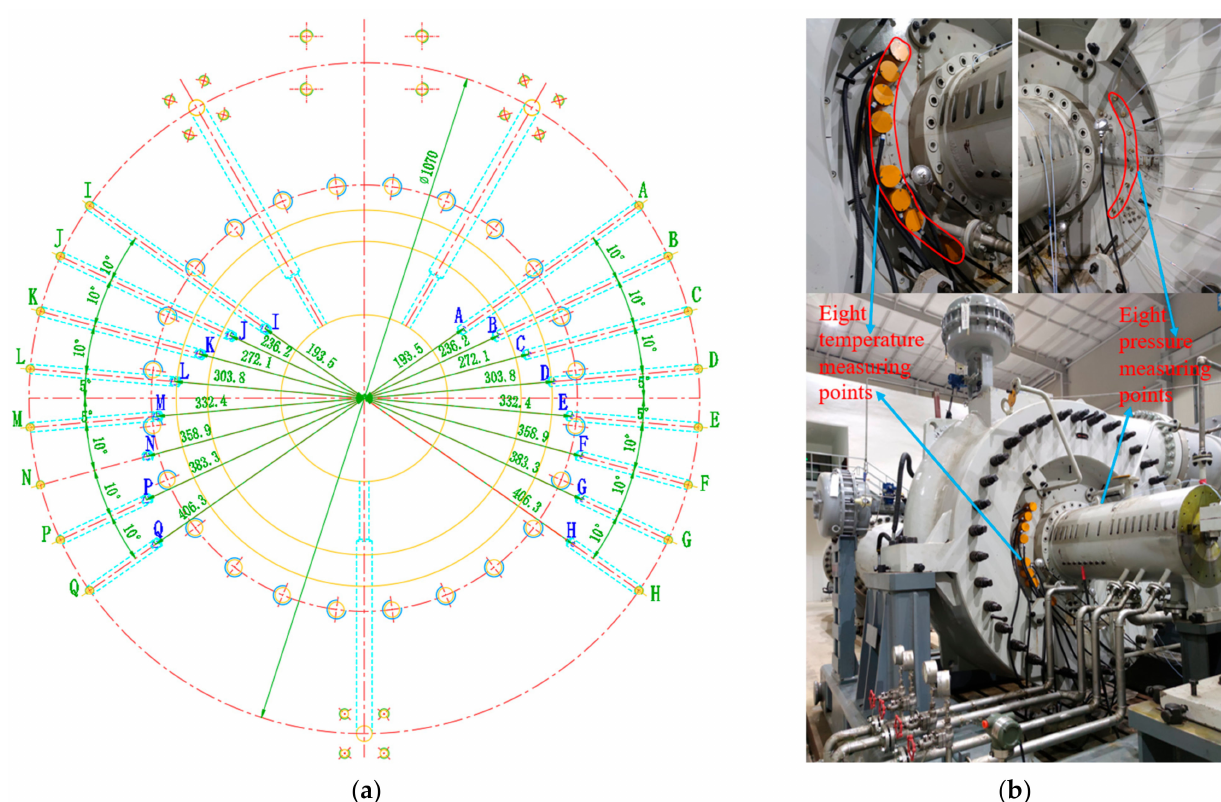
Figure 2. Specific location of measuring points and measurement site: ( a ) layout of the measuring points of IBC; ( b ) measurement site of